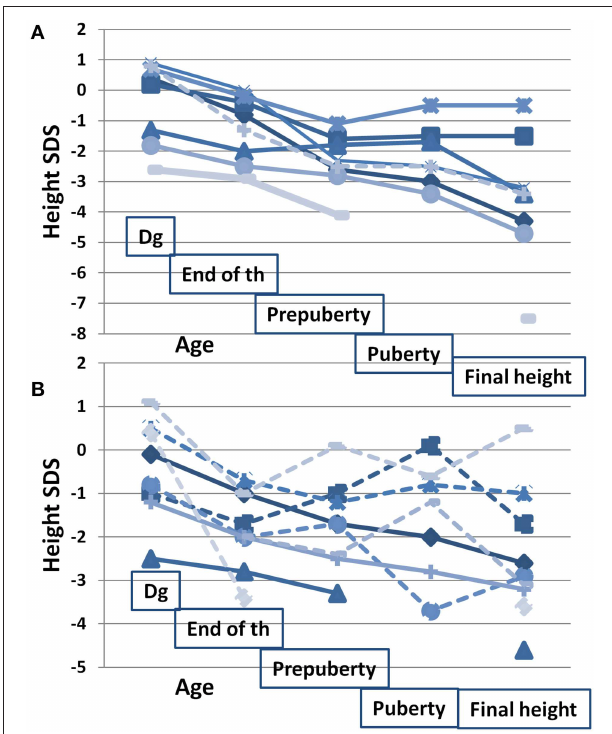
FIGURE 2 | Height SDS in relation to oncologic treatment and puberty in long-term survivors of HR-NBL ( n = 17). Height SDS measured at/before diagnosis (dg; median age at measurement 1.6 years, range 0.0–4.3), at the end of HR-NBL treatment (end of th; median 2.4 years, range 1.4–4.4), at pre-pubertal age (pre-puberty; median 7.8 years, range 6.5–8.8), at pubertal peak height velocity (puberty; median 13.1 years, range 11.8–14.8) and at final height. Growth patterns are shown separately for those with GH treatment (A) and for those without GH treatment (B) . Among the GH treated, GH treatment was started at mean age of 7.6 years (between 4 and 11). Those treated with TBI are marked with solid line and those without TBI with dotted line. Altogether 10 had hypothyroidism (7 with GH treatment; 3 without GH treatment) substituted with